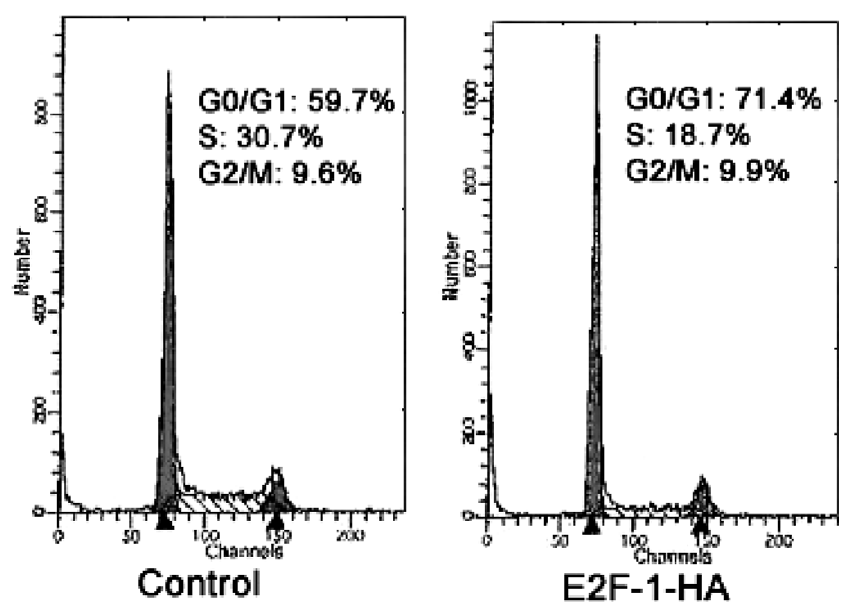
Fig. 7. Cell cycle analysis by flow cytometry in MKN-45 human gastric carcinoma cells transfected with E2F-1 . MKN-45 cells were transiently transfected with pCMV-E2F-1-HA ( E2F-1-HA ) or pCMV-HA ( Control ). The cells were harvested and stained at 48 h after transfection. The cell cycle distribution of the propidium iodide-labeled cells was analyzed by flow cytometry, as described in Patients and methods . The data are representative of three independent experiments. P < 0 . 05 for the G0/G1 population in control vs . E2F-1-HA